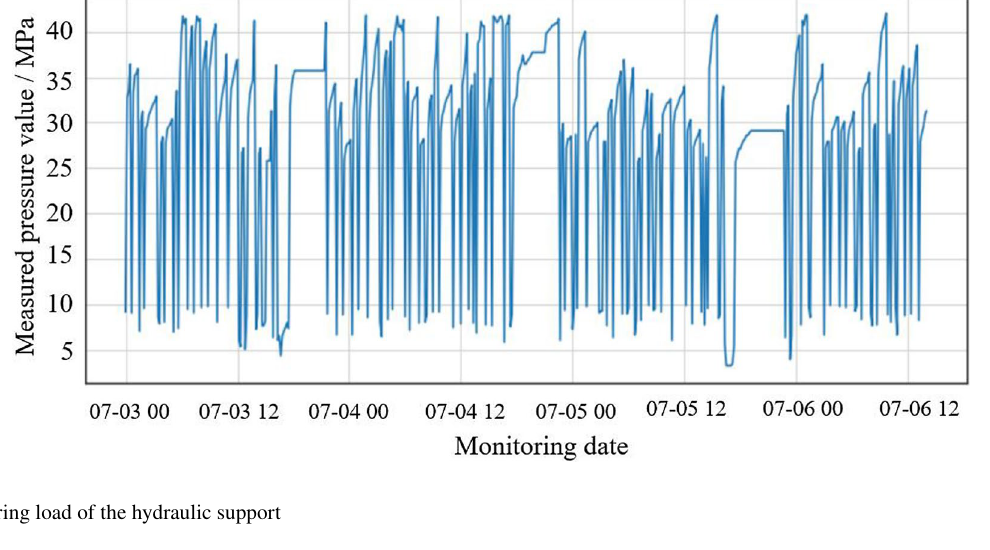
Fig. 4 Monitoring load of the hydraulic support